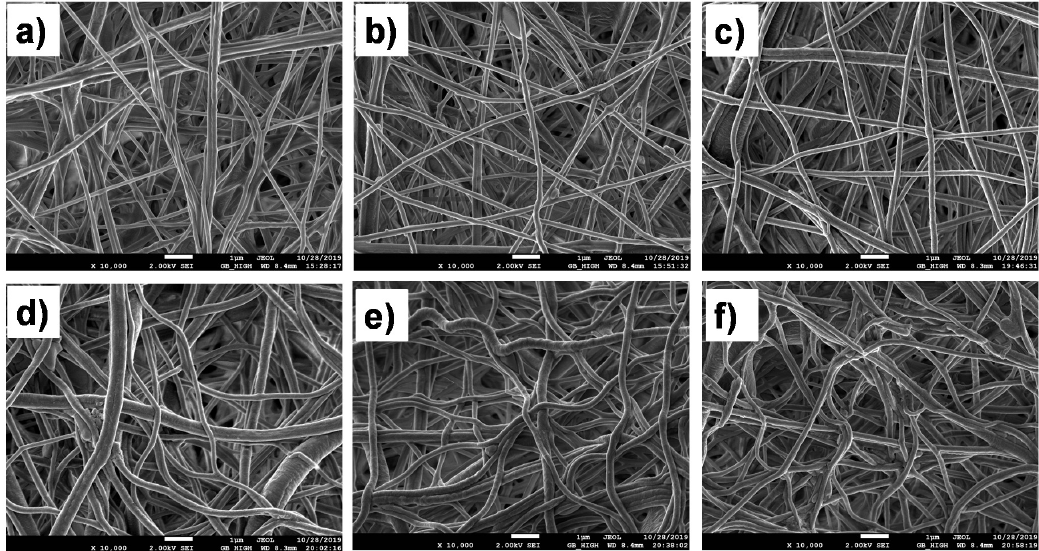
Figure 1. SEM micrographs of PCL-ref ( a ), PCL-Apo ( b ), PCL-ANG ( c ), PCL-COOH ( d ), PCL-COOH-Apo ( e ) and PCL-COOH-ANG ( f ). The size of the bar is 1 µm.